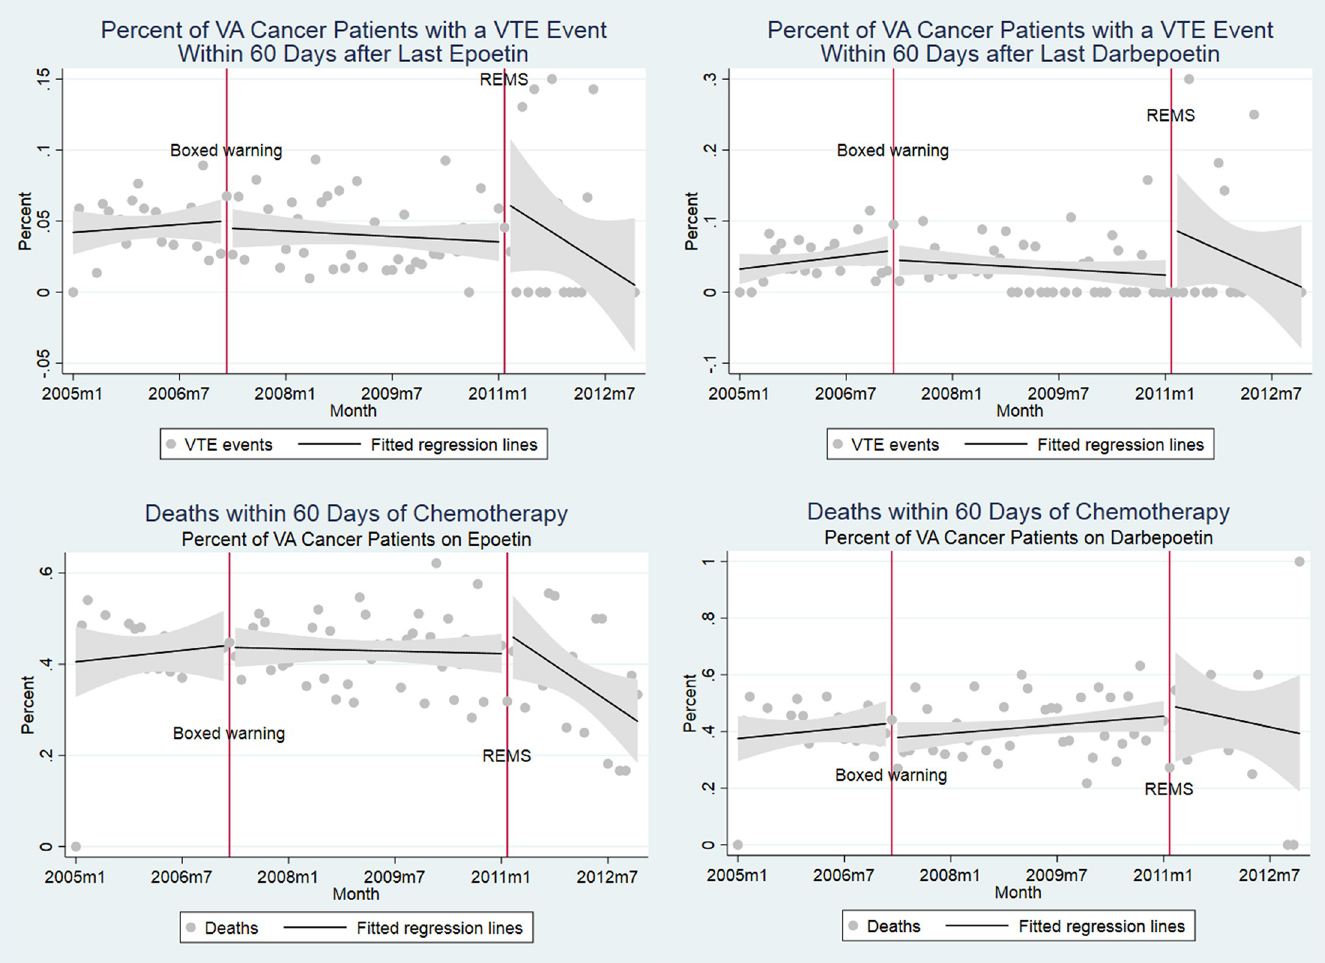
Fig 2. Percent of VA cancer patients within 60 days (a) VTE event after epoetin, (b) VTE event after darbepoetin, (c) death after chemotherapy—epoetin and (d) death after chemotherapy—darbepoetin.